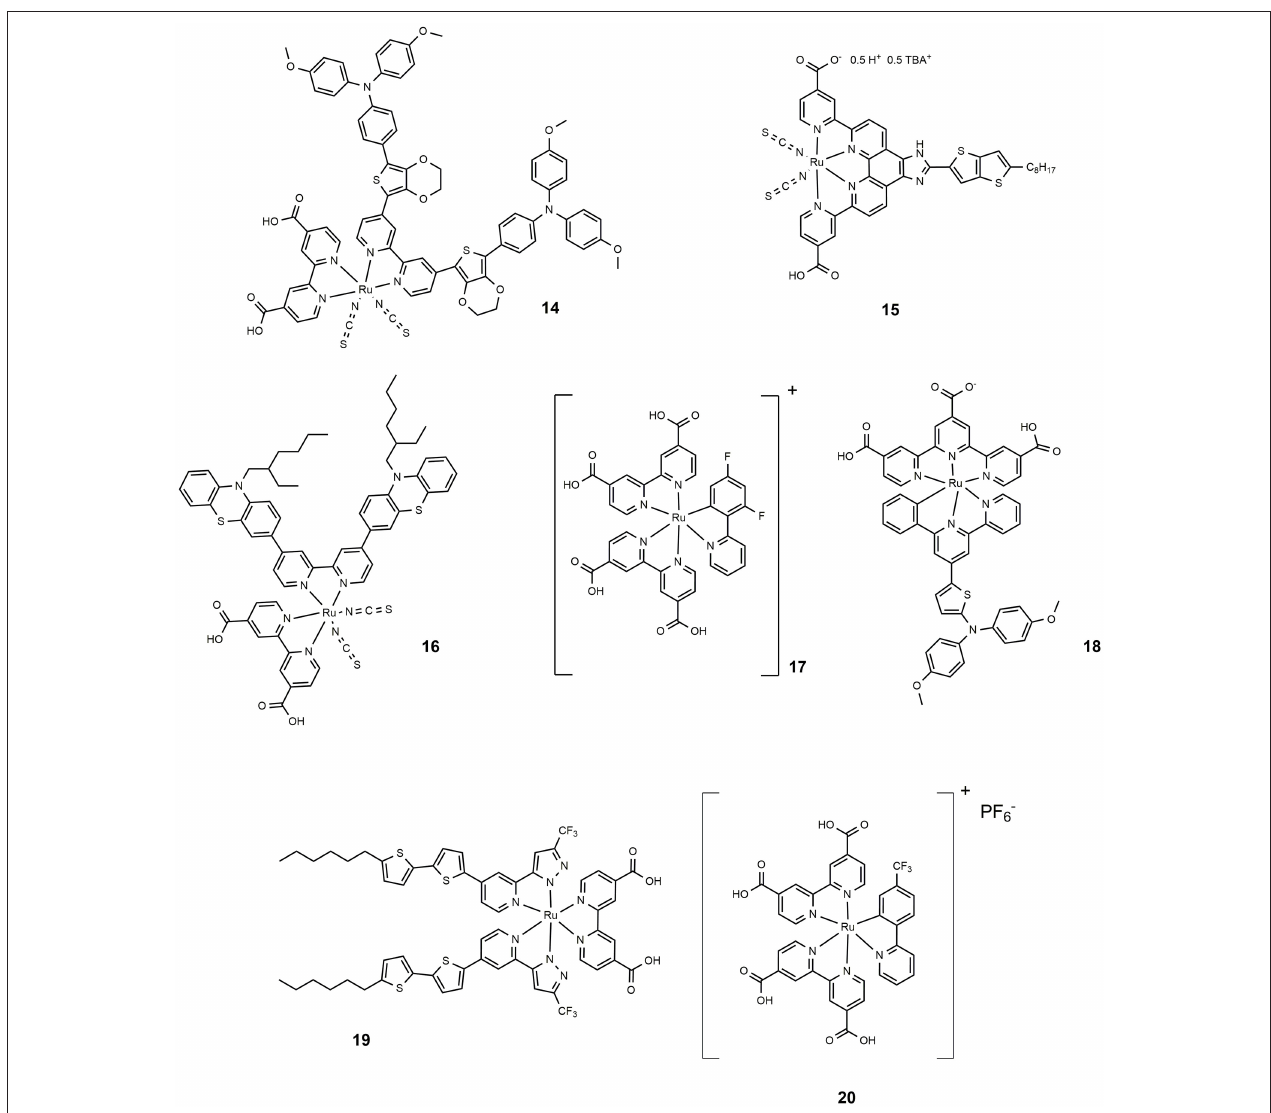
FIGURE 3 | Chemical structure of dyes